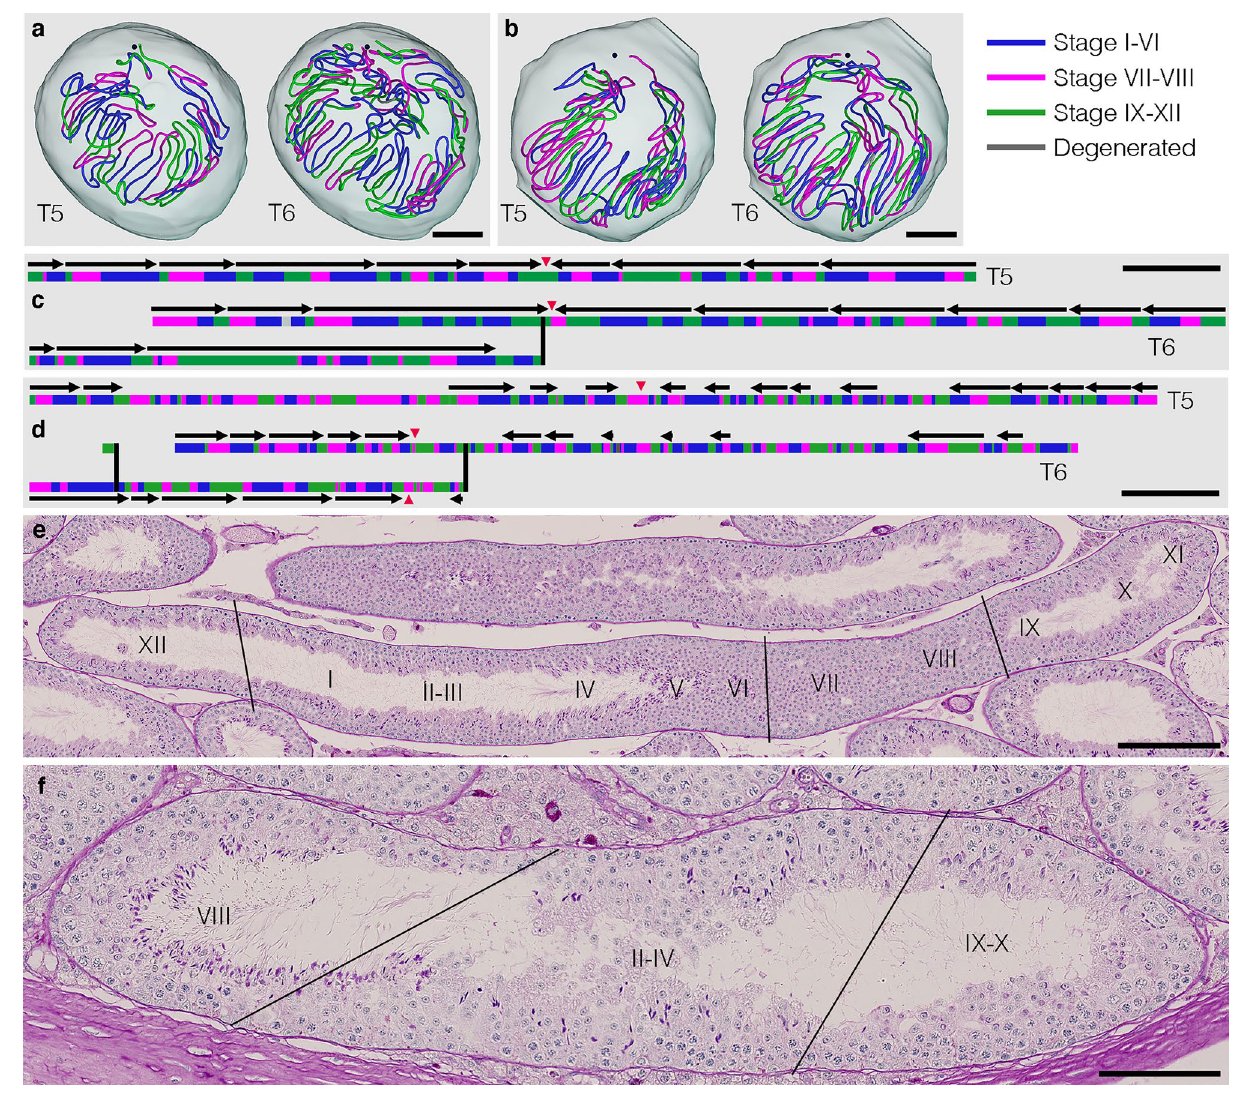
Figure 6. Distribution of spermatogenic stages and waves at 12 ( a , c ) and 30 ( b , d ) months. The core lines of reconstructed T5 and T6 tubules in testes #2 (12 months) and #10 (30 months) are shown in a horizontal view with the 3 + 1 different stage groups being marked in different colors and the positions of the rete testis being shown with black spheres ( a , b ). The different stage groups are as follows: stages I–VI (blue), stages VII–VIII (pink), stages IX–XII (green), and degenerated (gray). The schemes of the T5 and T6 tubules in testes #2 and #10 are shown in ( c ) and ( d ), respectively. The segments belonging to the 3 + 1 stage groups are marked with the corresponding colors. Horizontal arrows indicate the scopes and directions of waves. PAS-H-stained sections of testis #11 (30 months), with changes in stages with short intervals ( e ) and the irregular appearance of non- adjacent stages ( f ), are shown. The roman numerals in ( e , f ) represent stages I–XII. Scales, 1 mm ( a , b ), 10 mm ( c , d ), 200 µm ( e ), and 100 µm ( f ).